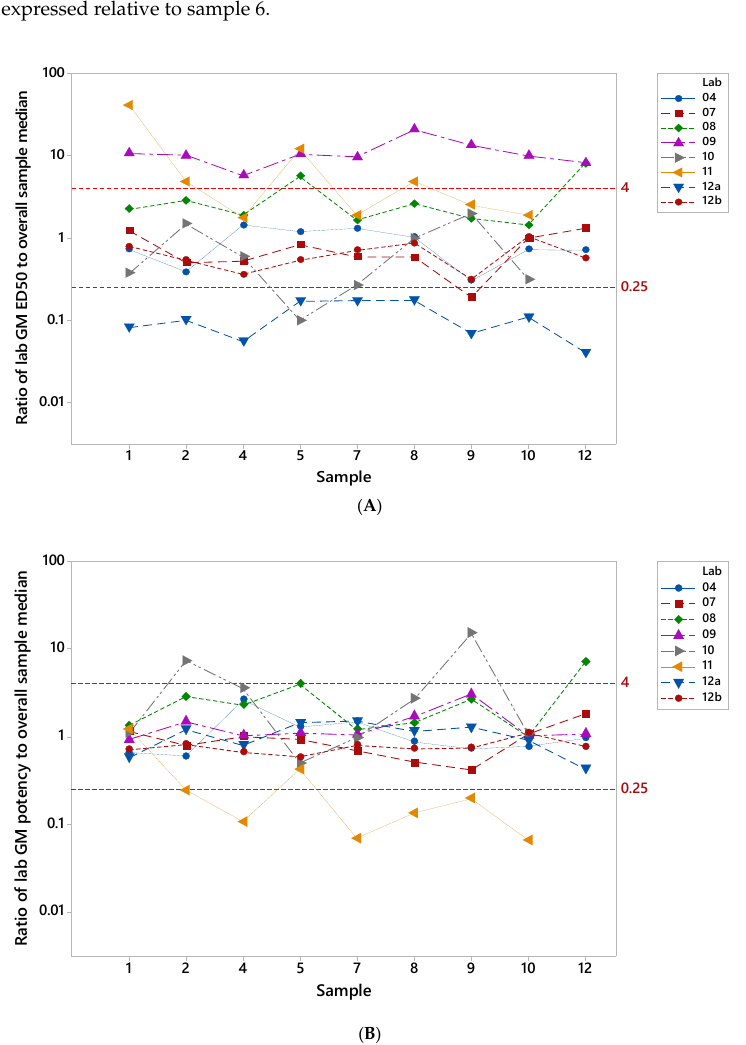
Figure 5. Inter-laboratory variability in ED50 and relative potency estimates . Individual points show the ratio of laboratory geometric mean ED50 estimates ( A ) and relative potency estimates ( B ) to the study median ED50 estimate for that sample; range of 0.25–4 is shown to indicate points that are no more than 4-fold different from the study median. Intra-laboratory variability (test repeatability within each laboratory) was assessed as ratios of the maximum and minimum ED50s or relative potencies for each sample in each laboratory (Figure 6 and Supplementary Tables S6 and S7). Normalization using sample 6 had no noticeable impact on intra-laboratory variability. The candidate standard was included twice in the blinded sample panel (samples 6 and 10), which also allows assessment of intra-laboratory variability; the relative potency